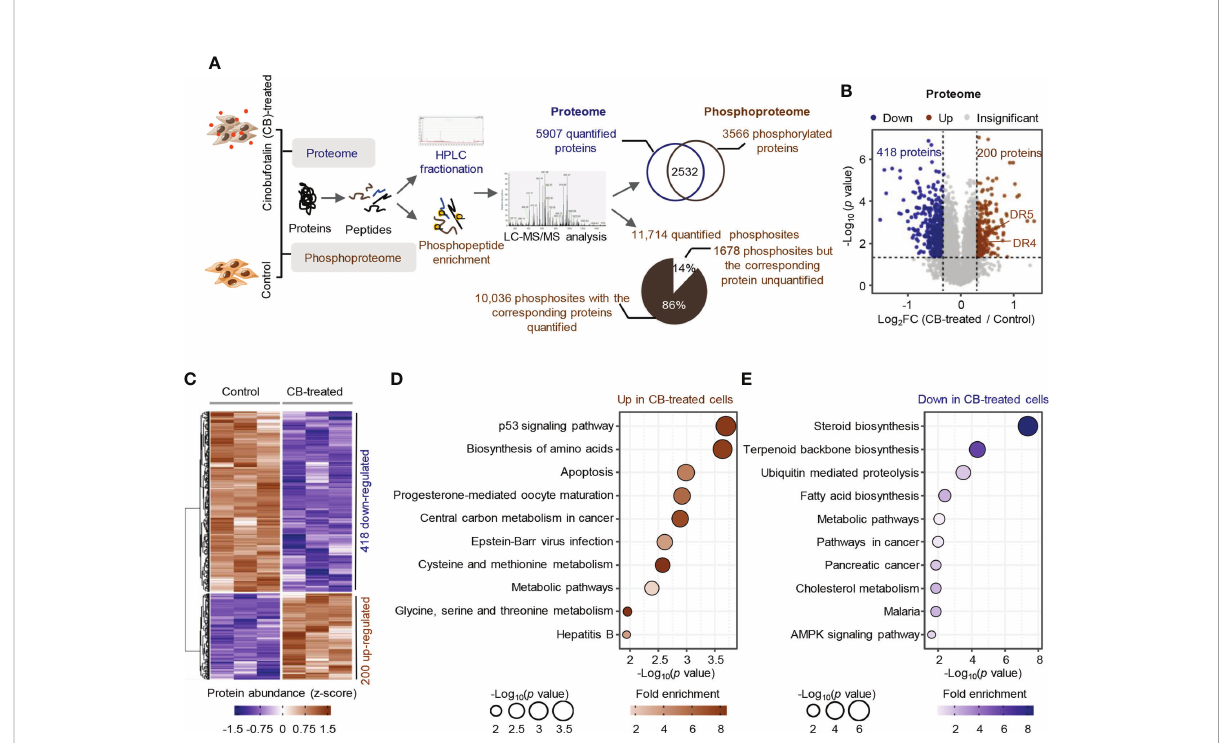
FIGURE 2 Proteome pro fi le of CB-treated RBE cells. (A) The work fl ow for the identi fi cation and quanti fi cation of proteins and phosphosites. (B, C) Volcano plot (B) and heatmap (C) of differentially expressed proteins ( p < 0.05 (Student ’ s t -test) and ratio (CB/Ctr) > 1.25 or < 0.8). Brown represents upregulated, blue means downregulated. (D, E) KEGG pathway analysis of signi fi cantly upregulated proteins (D) and downregulated proteins (E) . Circle size indicates the p value of enrichment, and the color shows the fold